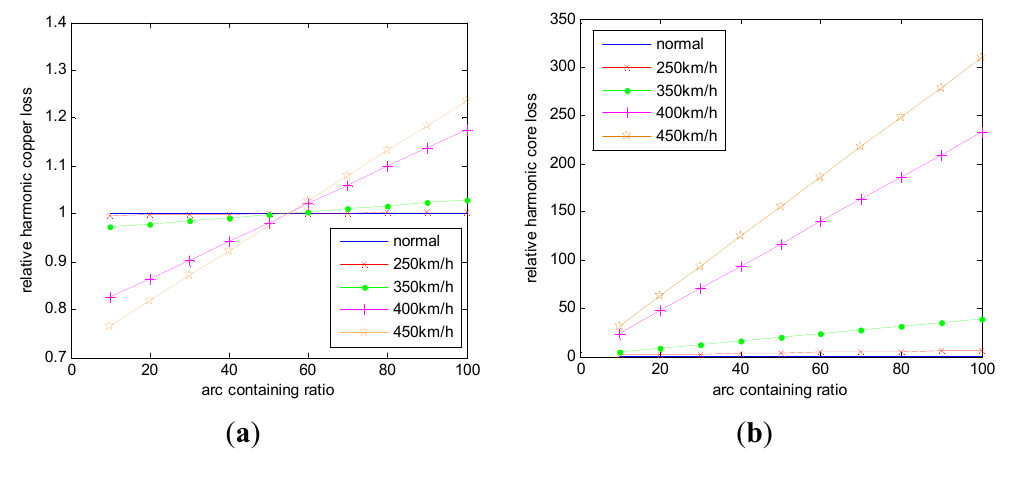
Figure 14. ( a ) Relative harmonic copper loss with different disconnection ratios. And ( b ) relative harmonic core loss with different disconnection